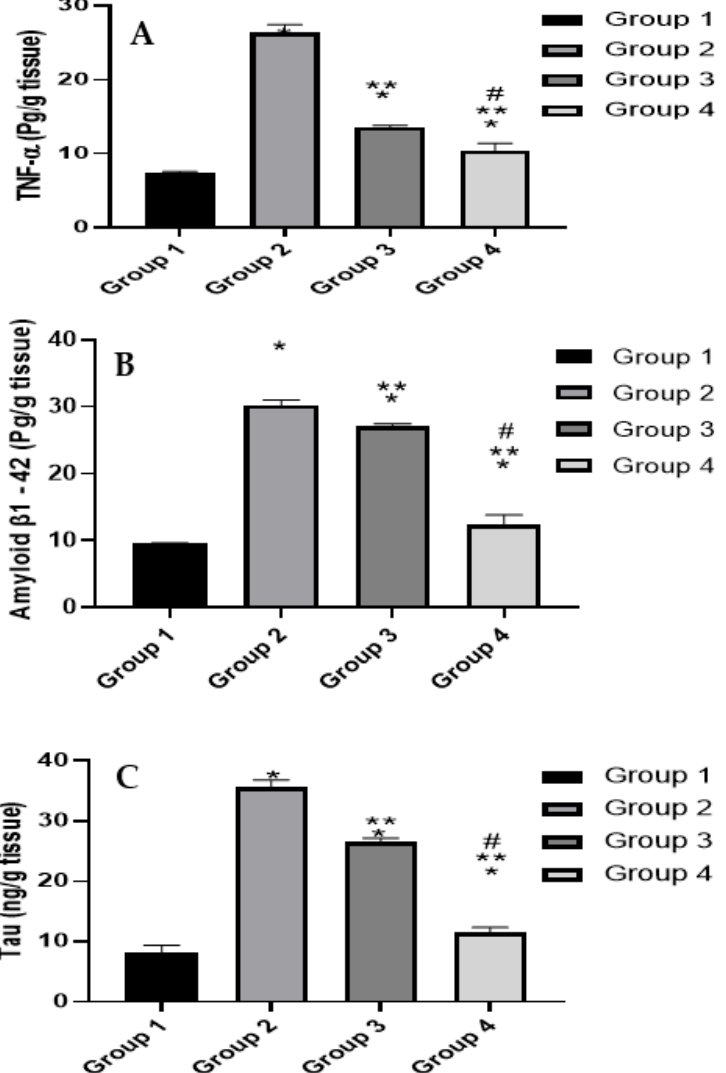
Figure 5. Biochemical analysis of ( A ) TNF- α level, ( B ) Amyloid β 1-42 level and ( C ) Tau level. Statistical analyses are performed using one-way analysis of variance (ANOVA) followed by Tukey-Kramer post-hoc test, whereby each value was presented as mean ± standard deviation (SD). * Statistically significantly different from the normal control group ( p < 0.05); ** statistically significantly different from the STZ group, 3 mg/kg ( p < 0.05); # statistically significantly different from the ART group 50 mg/kg ( p < 0.05).